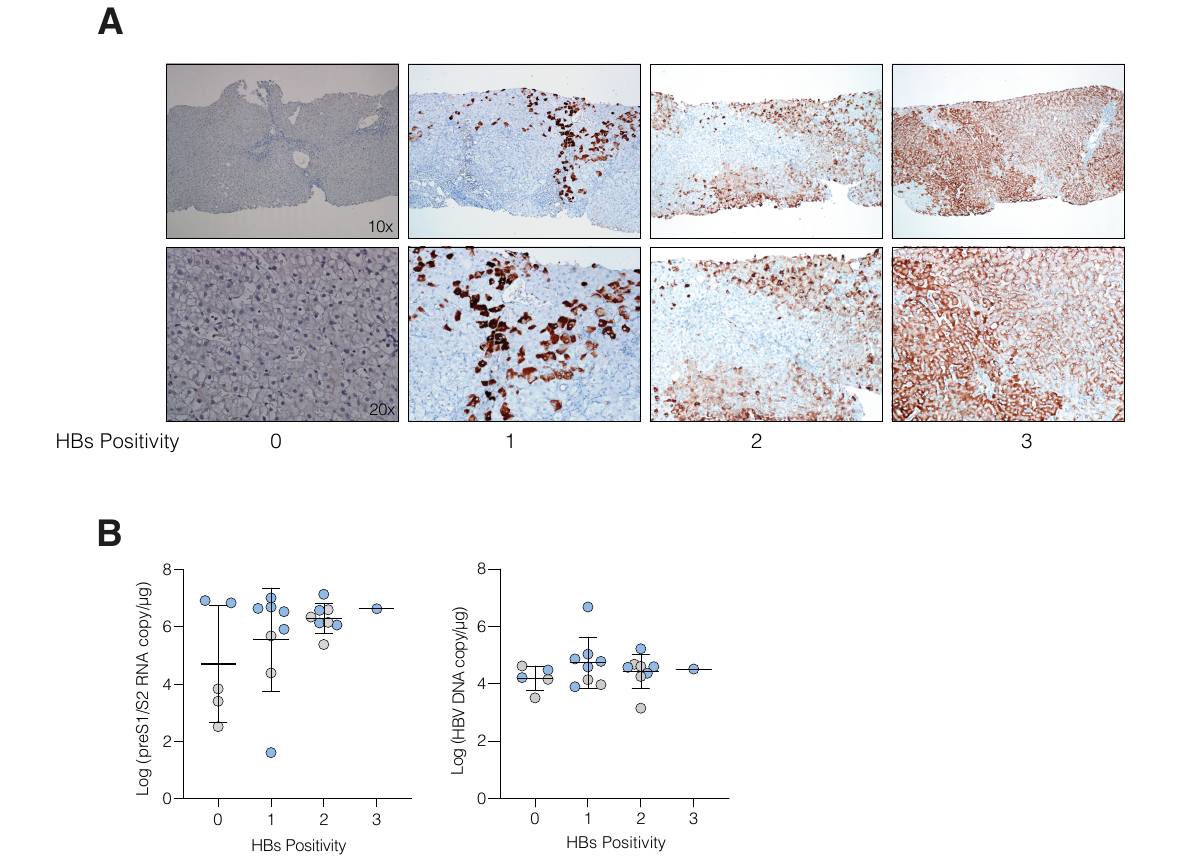
Figure 4. HBsAg liver staining and preS1/S1 RNA levels. ( A ) HBsAg immune staining in liver biopsies. Samples were scored based on the frequency of HBsAg-expressing cells, where 0 is negative, 1 is less than 33%, 2 between 33–66%, and 3 higher than 66%. Two magnifications are shown: 10 × ( top ) and 20 × ( bottom ). ( B ) Association between HBsAg score and preS1/S2 RNA copies ( left ) or total hepatic DNA ( right